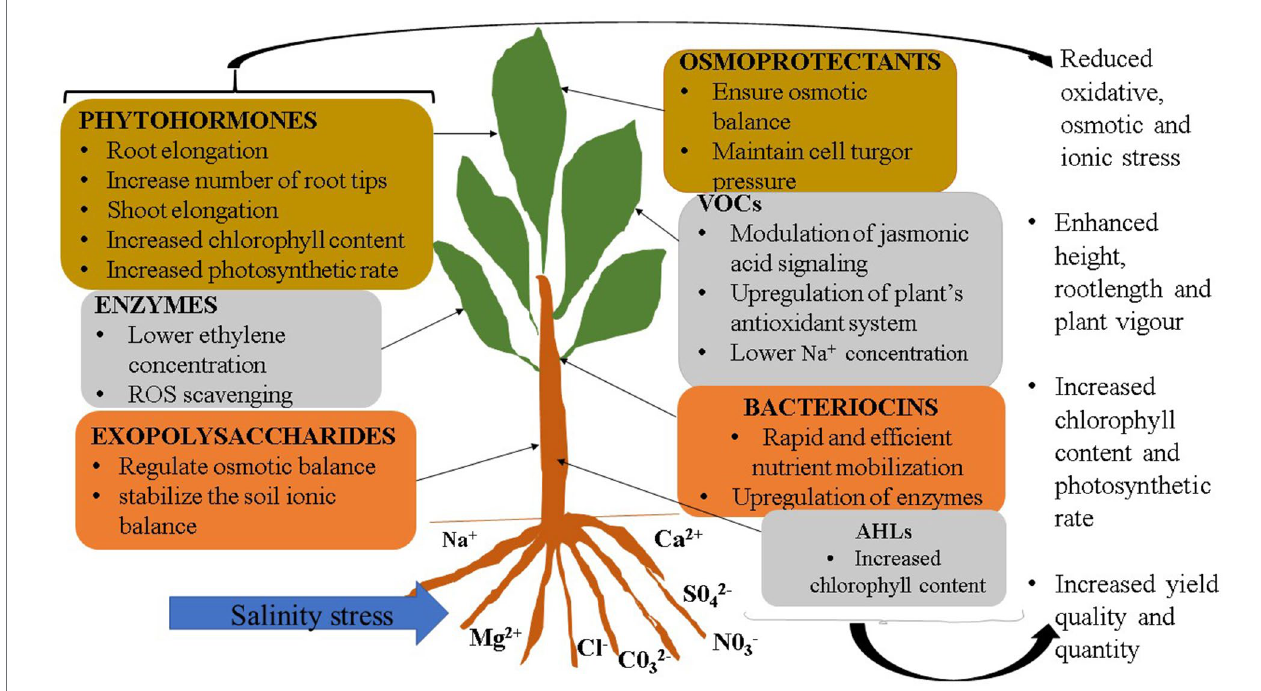
FIGURE 1 | Mechanisms employed by microbial derived compounds to mitigate salinity stress in